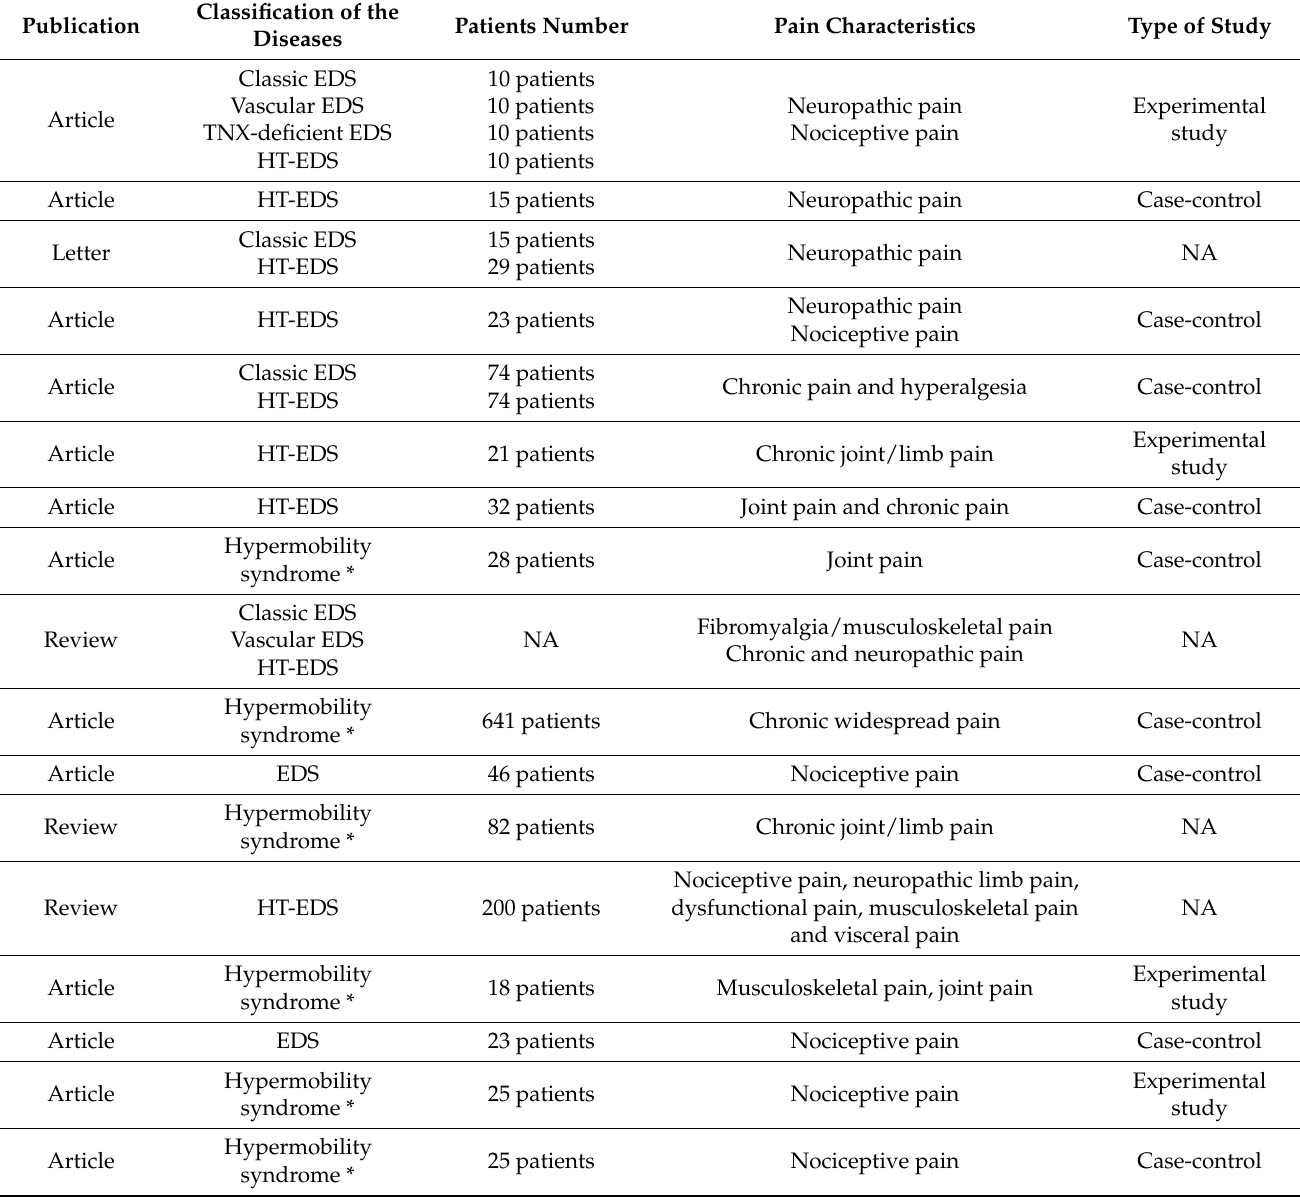
Table 1. The characteristics of pain in various forms of